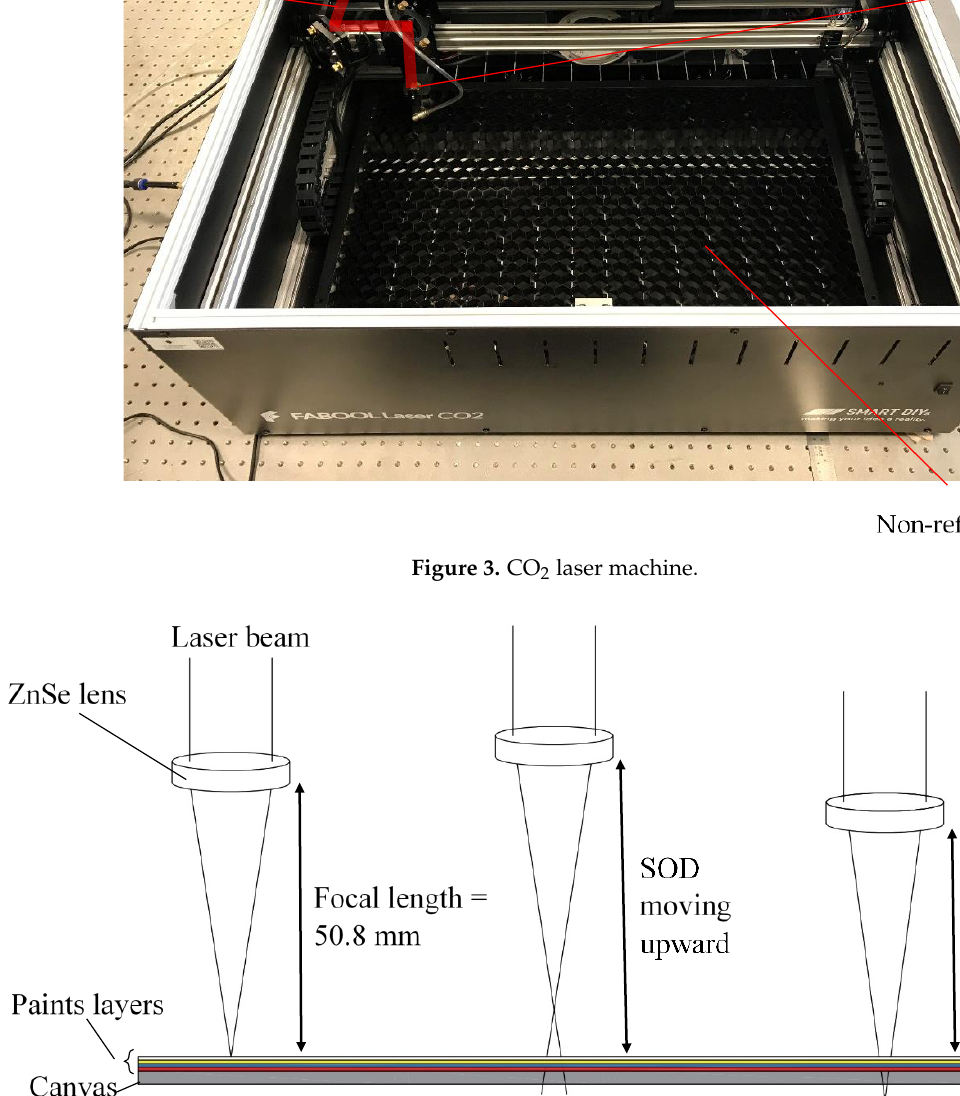
Figure 4. Schematic diagram of focal plane position and standoff distance relative to the surface of the workpiece, ( a ) ZnSe lens at focal length, ( b ) ZnSe lens at upper position, ( c ) ZnSe lens at lower position.